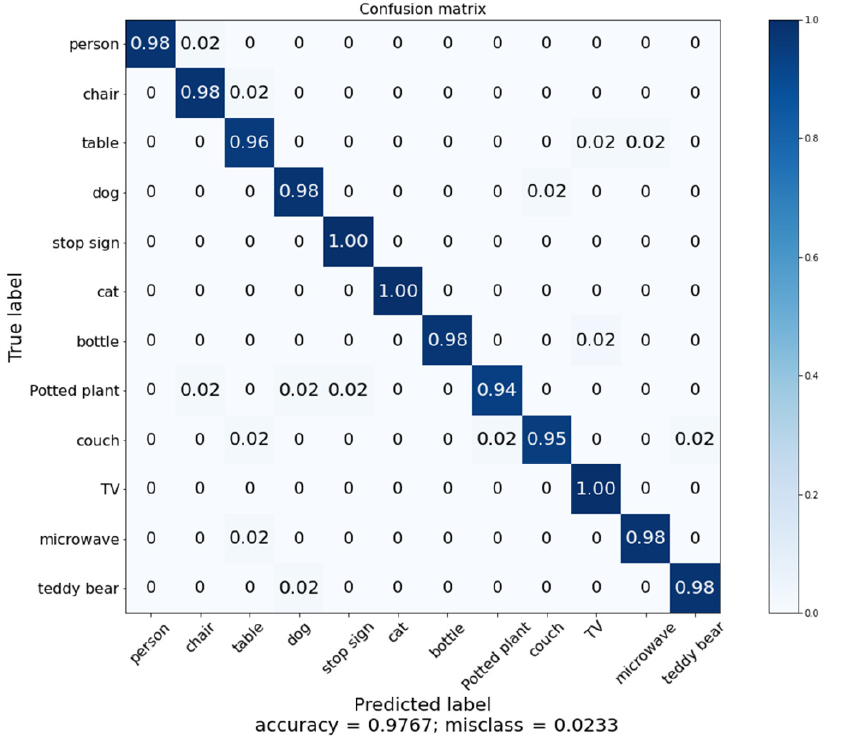
Figure 15. Confusion matrix for classification accuracy.